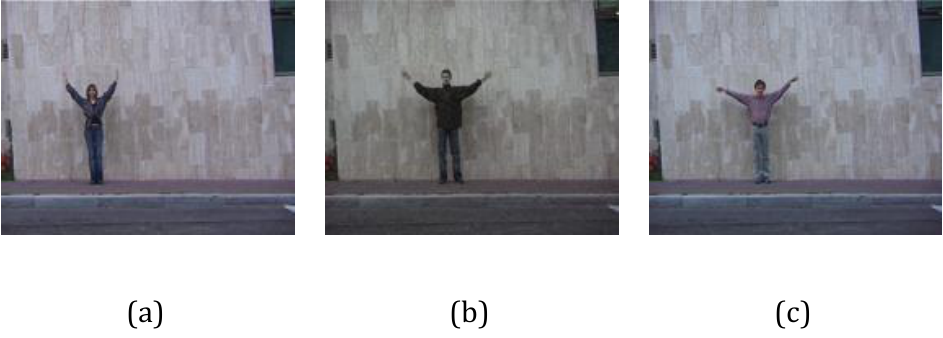
Figure 11. Abnormal “BHSW” actions. ( a ) Misclassification example; ( b , c ) Un-Classification